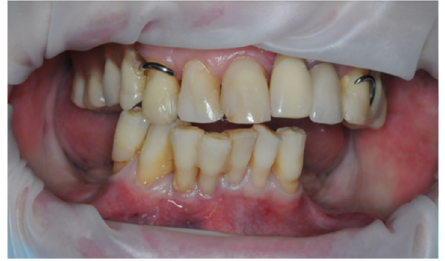
Figure 8. Patient’s occlusion at T0.